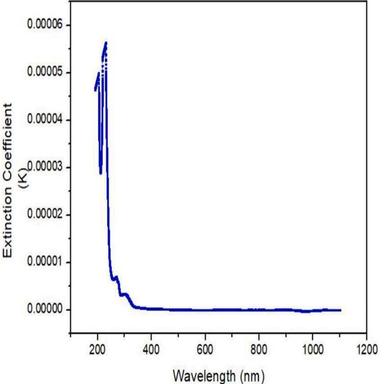
G4C3NBM's plot of Extinction coefficient with wavelength.